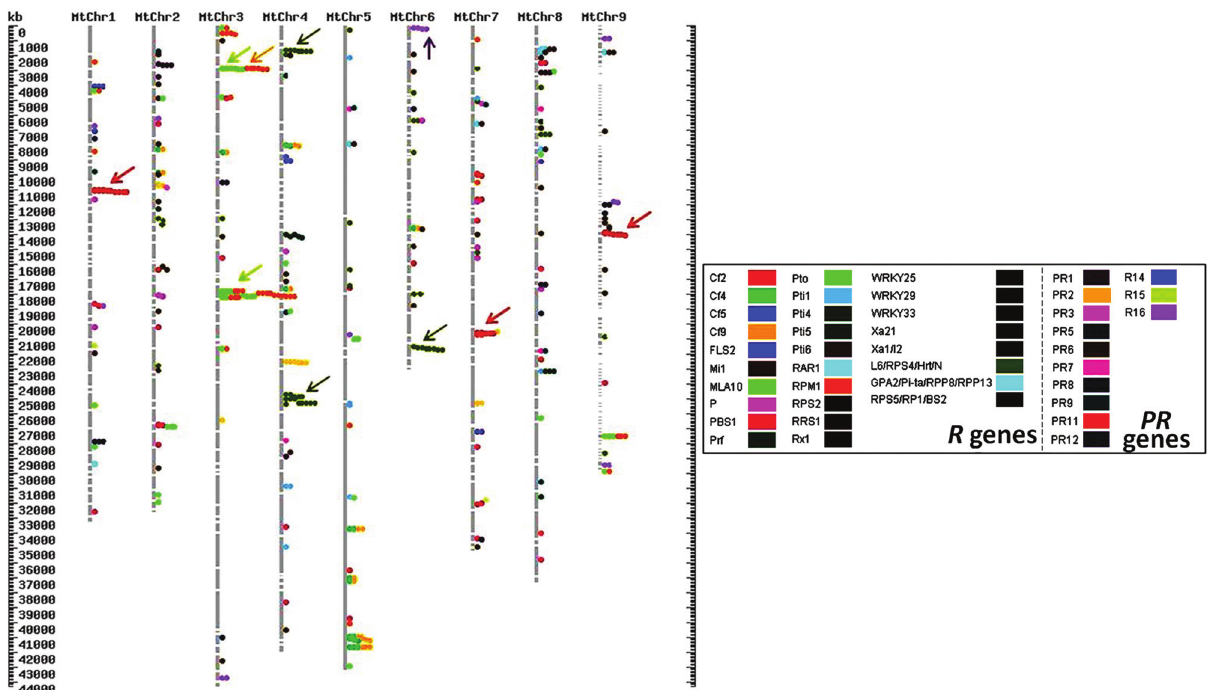
Figure 6 - Graphic representation of soybean R and PR sequences positioned on Medicago truncatula chromosomes (MtChr) with the aid of the CVit-BLAST resource available at the website http://www.medicago.org/. Arrows indicate genes that appear in tandem